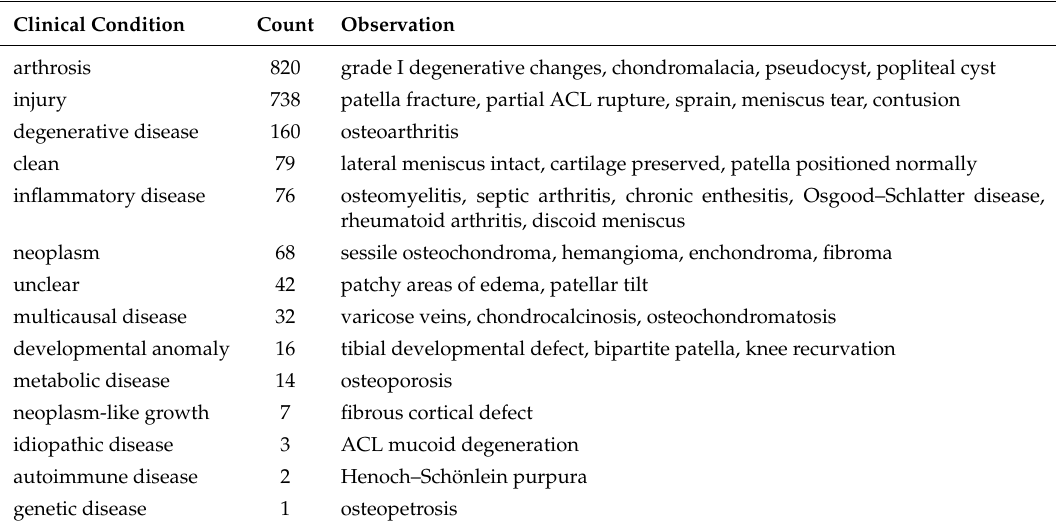
Table 1. Number of occurrences (counts) of distinct clinical conditions and examples of phrases indicating the clinical conditions. These phrases were the most frequently occurring in the used collection of unstructured radiology